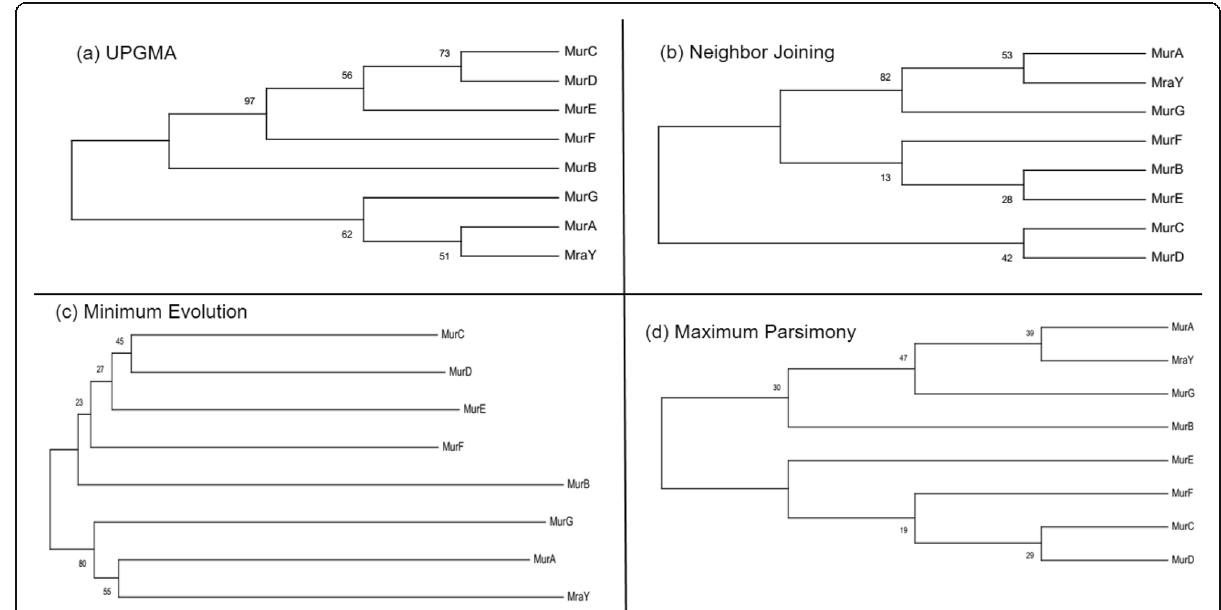
Fig. 1 Phylogenetic tree construction of eight Mur proteins from A . baumannii . Tree was constructed by a UPGMA, b neighbor-joining, c minimum evolution, and d maximum parsimony methods. Topology was also evaluated by bootstrap analysis via MEGA X. The numerical values in the tree represent bootstrap results